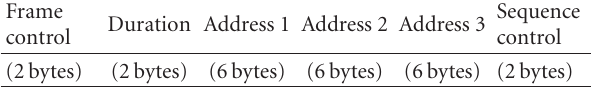
Table 2: Medium access control header.